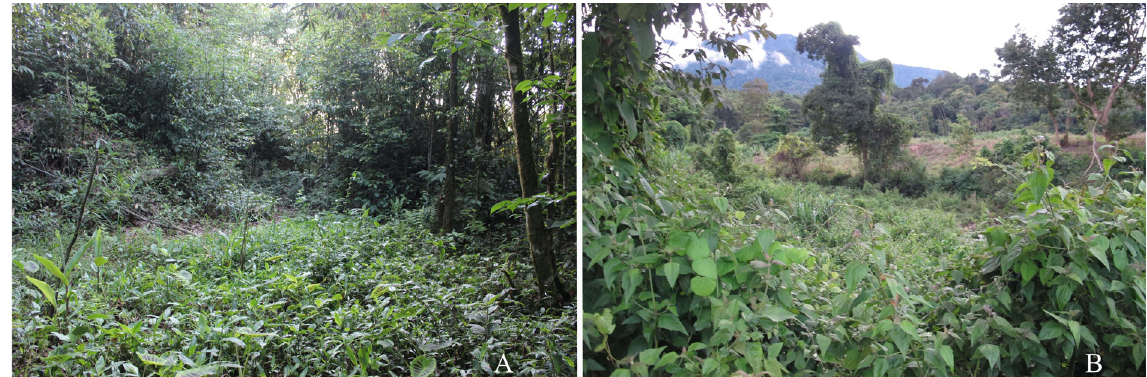
Fig. 7. A . Habitat of Microhyla hmongorum sp. nov. in Tam Duong District, Lai Chau Province, Vietnam. B . Habitat of Microhyla xodangorum sp. nov. in Kon Plong District, Kon Tum Province, Vietnam. Photos by C.V.